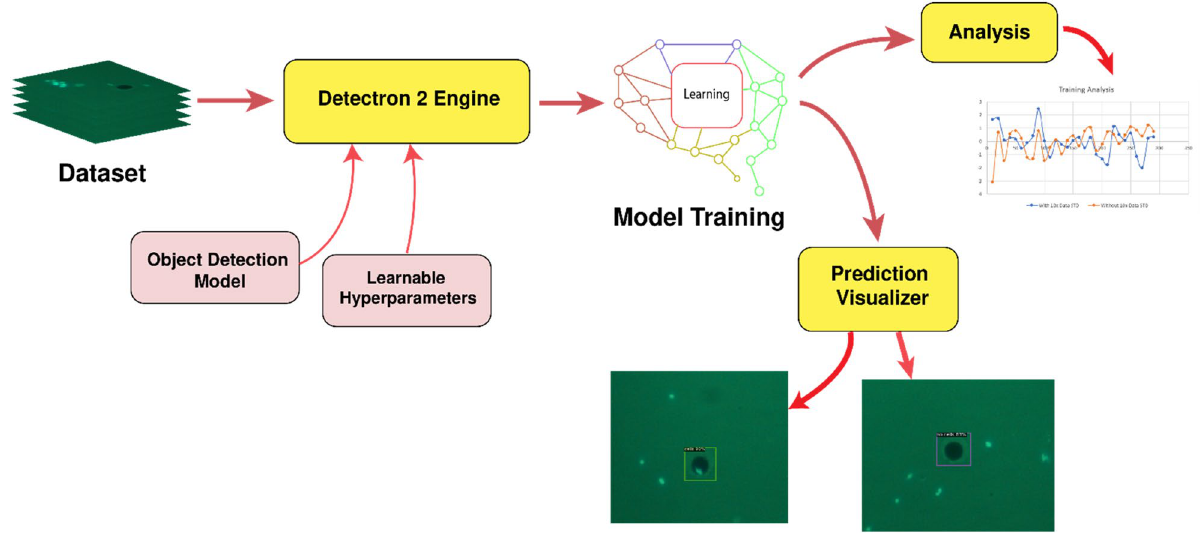
Figure 3. The overall workflow of the cell detection setup based on Detectron2. The analysis section doesn’t necessarily come as a part of the pipeline and is used to test the efficiency of the model and interpret the generated results. Visualizing predictions is preferred for any real-life implementations.